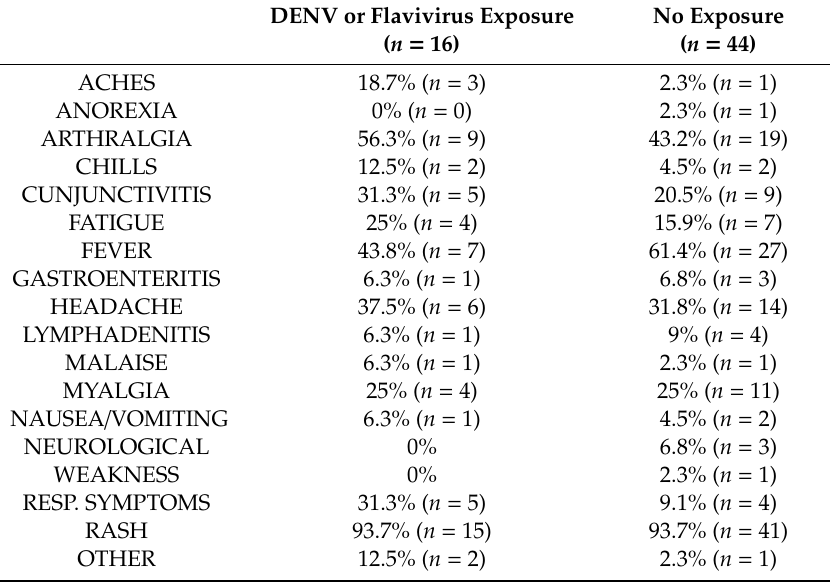
Table 3. Summary of clinical symptoms reported at